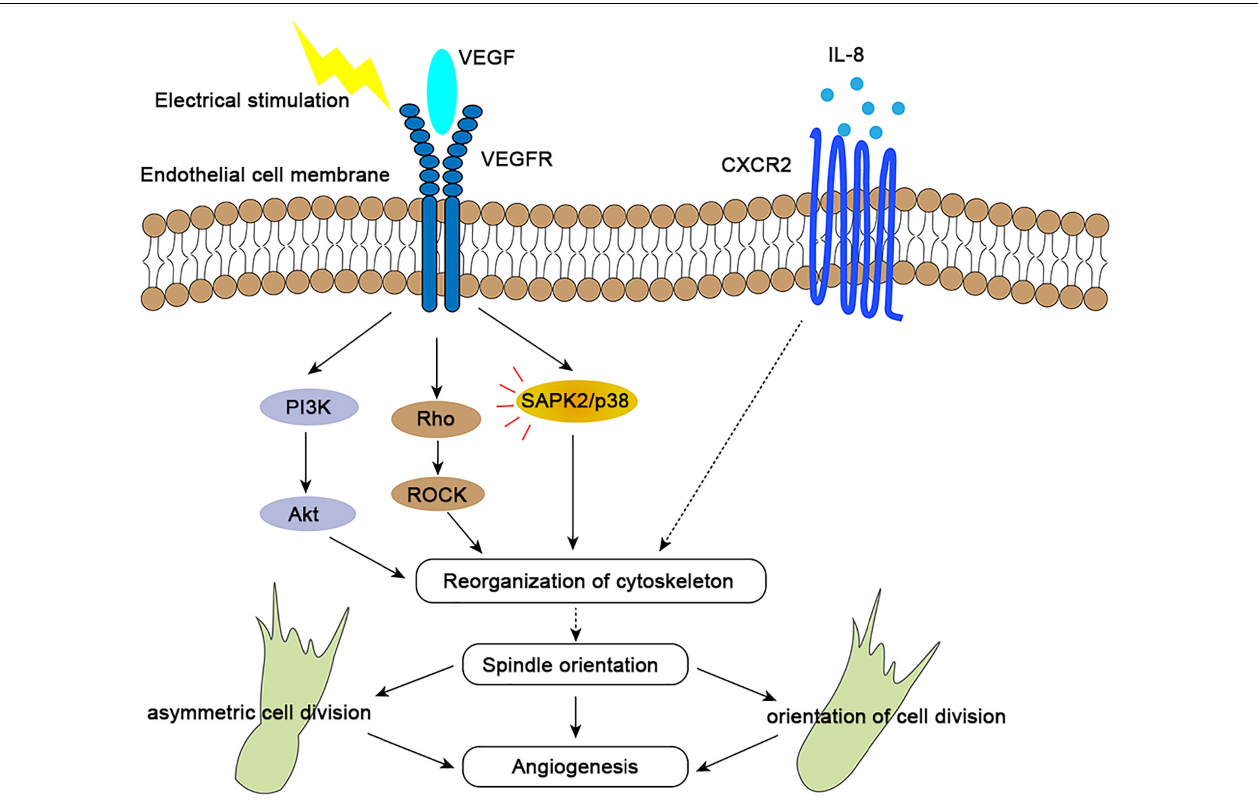
FIGURE 2 | Molecular mechanisms of spindle orientation effects in angiogenesis. By binding to VEGFR2, VEGF activates the PI3K/Akt, Rho/ROCK, and SAPK/p38 signaling pathways (red lines), which results in precise orientation of the mitotic spindle, endothelial cell asymmetry and orientation, and consequent directional angiogenesis. Interleukin-8 (IL-8) binds with high affinity to the chemokine receptor CXCR2, which may also regulate spindle orientation by influencing reorganization of cytoskeleton to further affect spindle orientation, further impacting angiogenesis. Both receptors and signaling pathways are upregulated upon electrical